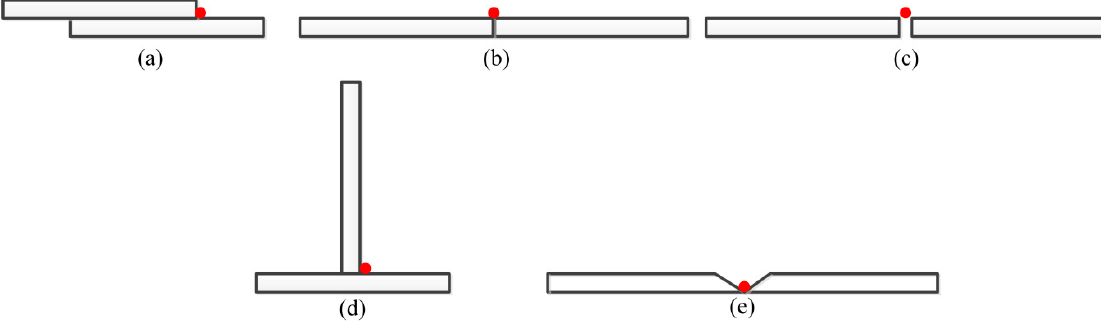
Figure 3. Weld joint types: ( a ) lap weld joint, ( b ) butt weld joint, ( c ) splice weld joint, ( d ) fillet weld joint, and ( e ) v-type weld joint.